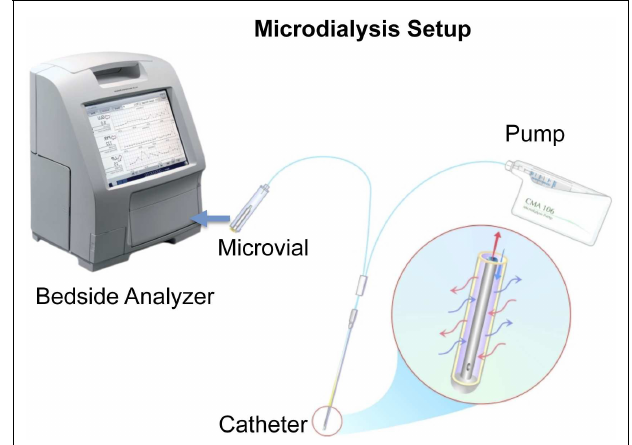
FIGURE 1 |A schematic picture of microdialysis setup is presented courtesy of M dialysisAB .The catheter is inserted in the brain tissue and a physiological salt solution is slowly and constantly pumped through a semipermeable membrane.This dialysis membrane at the distal end of the microdialysis catheter functions like a blood capillary. Chemical substances from the extracellular fluid diffuse across the membrane into the perfusion fluid inside the catheter.The “microdialyzate” is then collected in a microvial and analyzed in the bedside analyzer